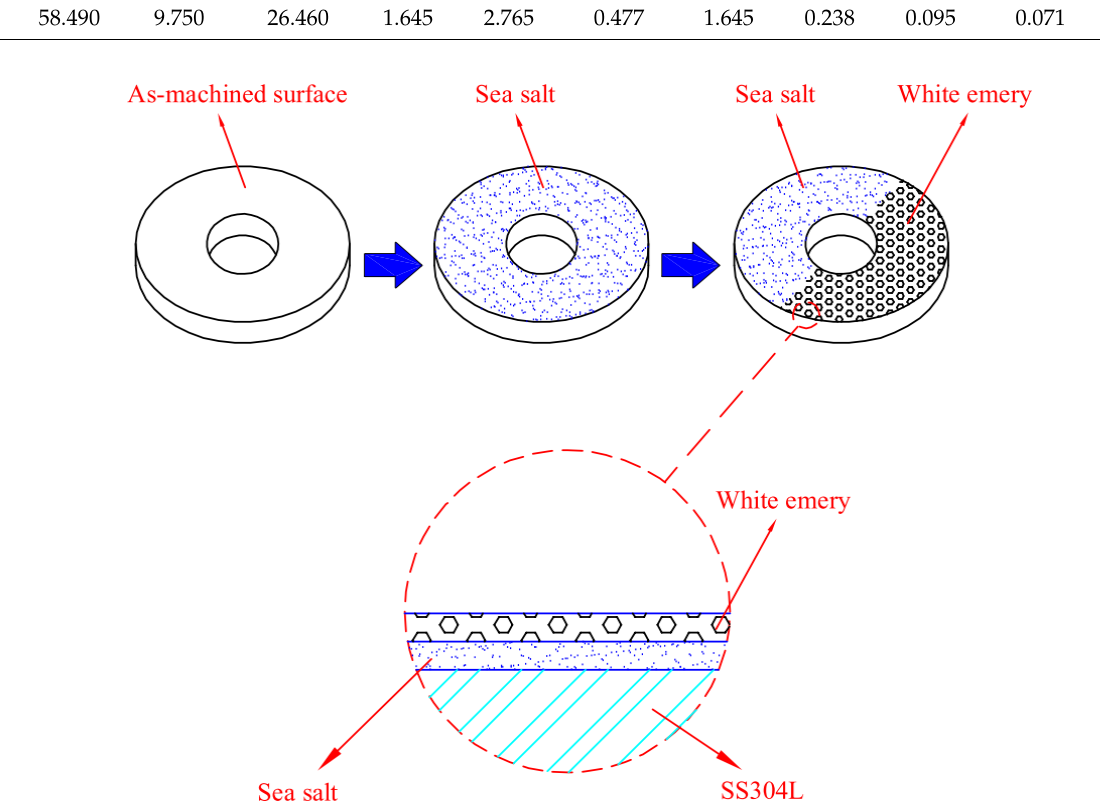
Figure 2. Schematic diagram of the specimen sprayed with synthetic sea water and white emery.